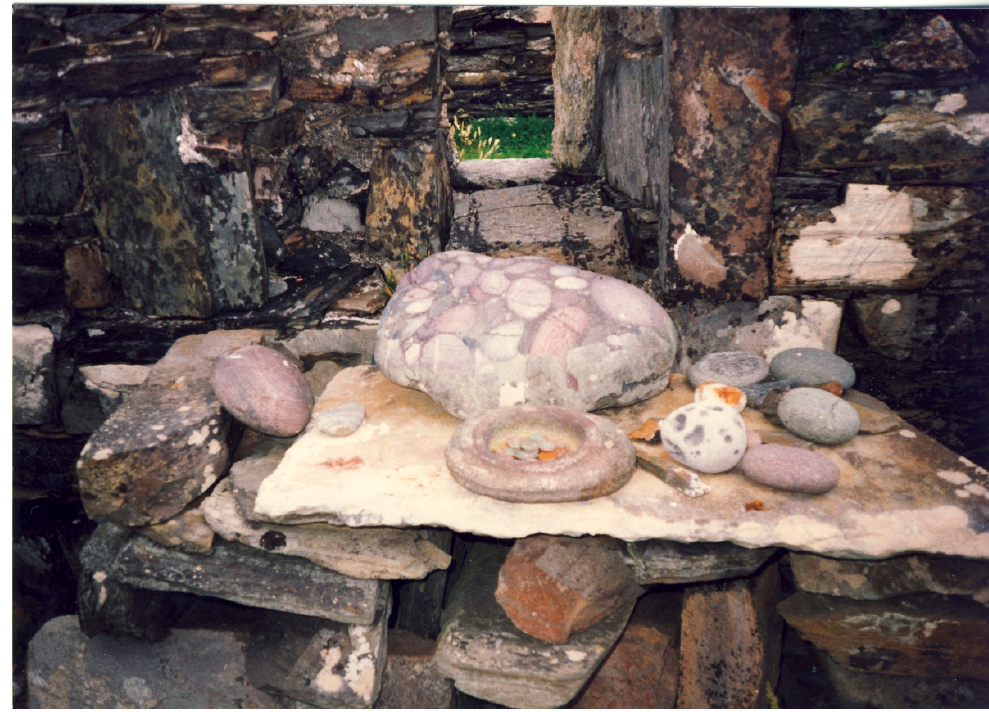
Figure 11. Leac na Naomh (the Saint’s Stone) on Caher Island. Near Blacklion (Co. Cavan), there were at least nine bullauns with one rounded stone